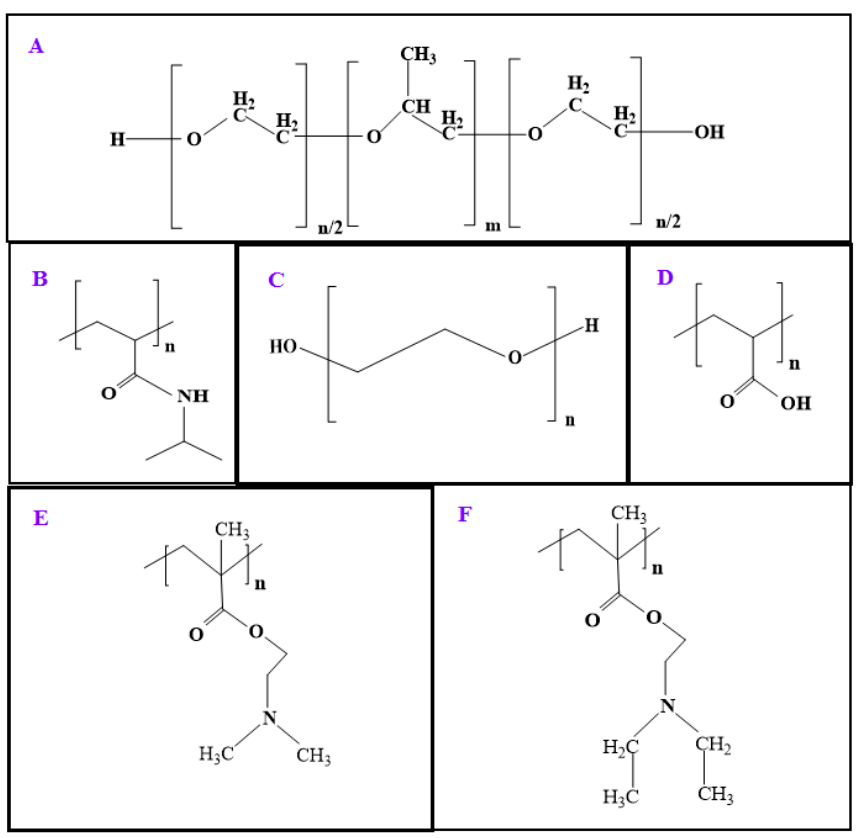
Figure 5. The chemical structure of the thermo-responsive synthetic polymers, PF127 ( A ), pNIPAAm ( B ), and the pH-responsive synthetic polymers, PEG ( C ), PAA ( D ), PDMAEMA ( E ), and PDEAEMA ( F ).